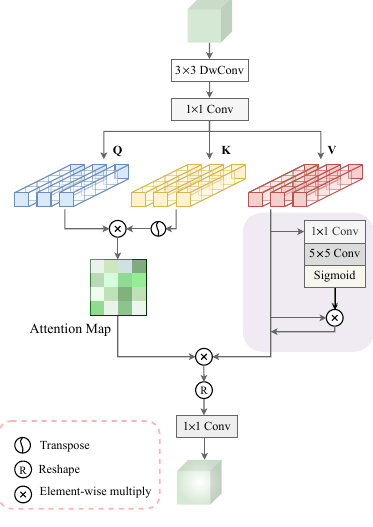
Figure 5. The self-attention mechanism in